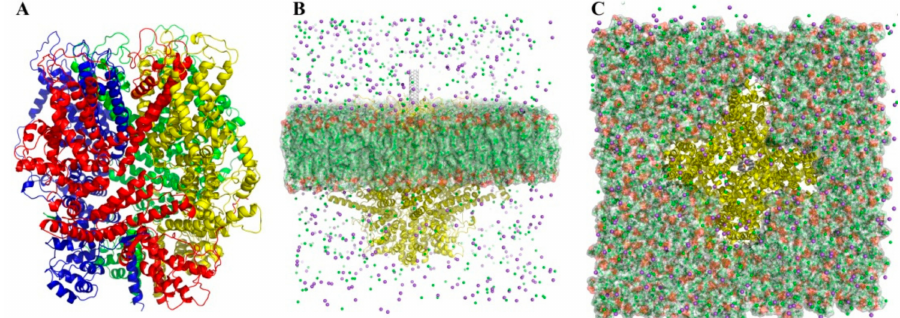
Figure 1. ( A ) Molecular model of receptor-operated TRPC4 cation channel (PDB ID 5Z96) with its four subunits shown by different colors: subunit A—red, subunit B—blue, subunit C—green, and subunit D—yellow. ( B ) Profile view of TRPC4 channel. ( C ) Top view of TRPC4 channel. In both ( B ) and ( C ), the plasma membrane is highlighted in green, and an example of single-walled carbon nanotube (SWCNT) docked into the TRPC4 channel pore is shown in